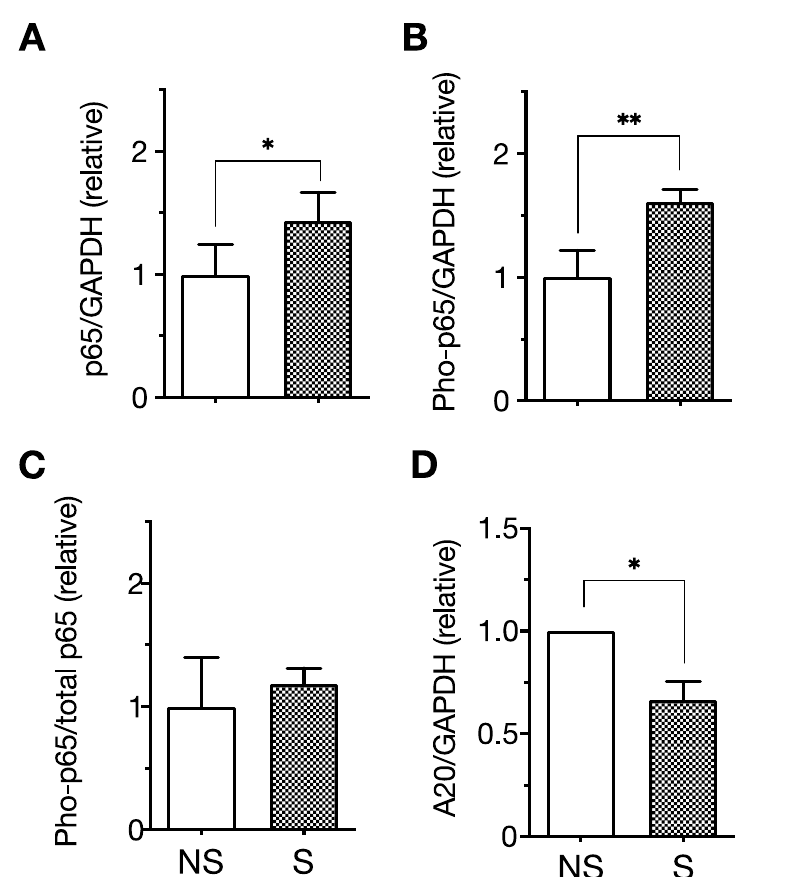
Figure 2. The expression of NF- κ B p65 and A20 in senescent endothelial cells. The expression of p65, phosphorylated p65 (Pho-p65), and A20 (a negative regulator of NF- κ B) was analyzed with senescent (S) and non-senescent (NS) human umbilical vein endothelial cells (HUVECs) by Western blotting. The relative expression of total p65:GAPDH ( A ), Pho-p65:GAPDH ( B ), Pho-p65:total p65 ( C ), and A20:GAPDH ( D ) of senescent cells was expressed as a ratio to non-senescent cells. Data are the mean ± standard deviation (SD) of six independent experiments. Values were compared between senescent and non-senescent cells. The expression of total p65 and Pho-p65 was upregulated in senescent cells. In contrast, the expression of A20 was downregulated in senescent cells. * p < 0.05, ** p < 0.01 [93].